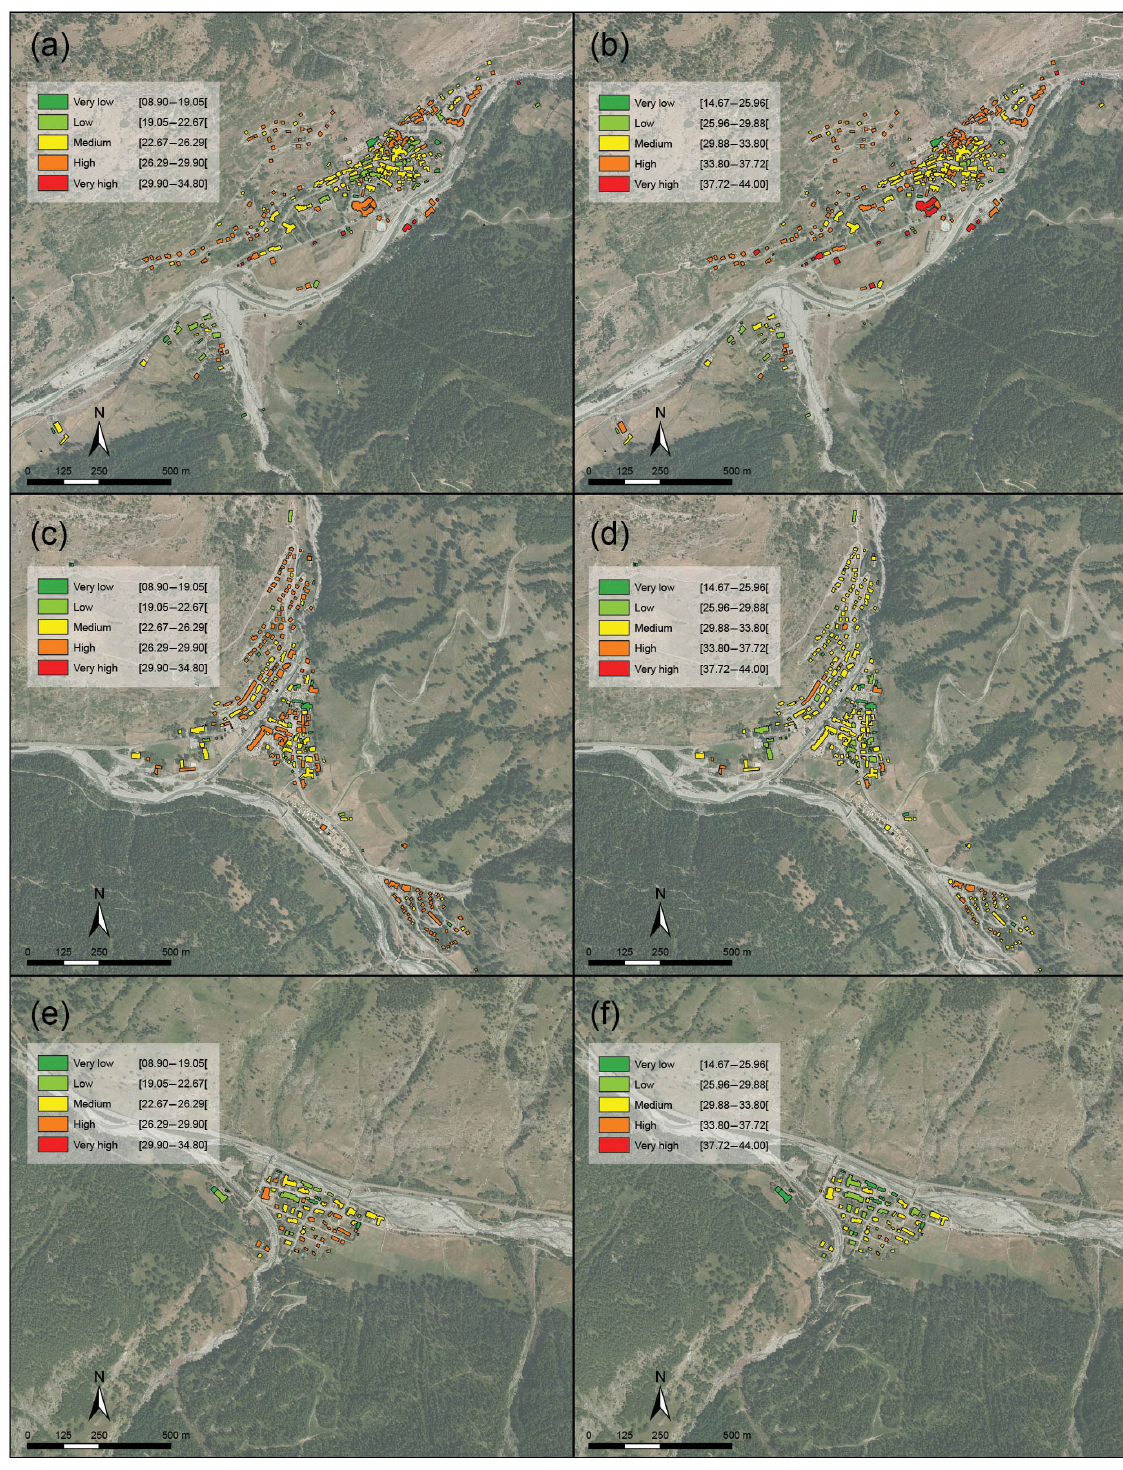
Figure 6. Comparison between PDI and PCI maps. (a) Close-up of PDI map produced for the village of Aiguilles; (b) close-up of PDI map produced for the village of Abriès; (c) close-up of PDI map produced for the village of Ristolas; (d) close-up of PCI map produced for Aiguilles; (e) close-up of PCI map produced for Abriès (f) close-up of PCI map produced for